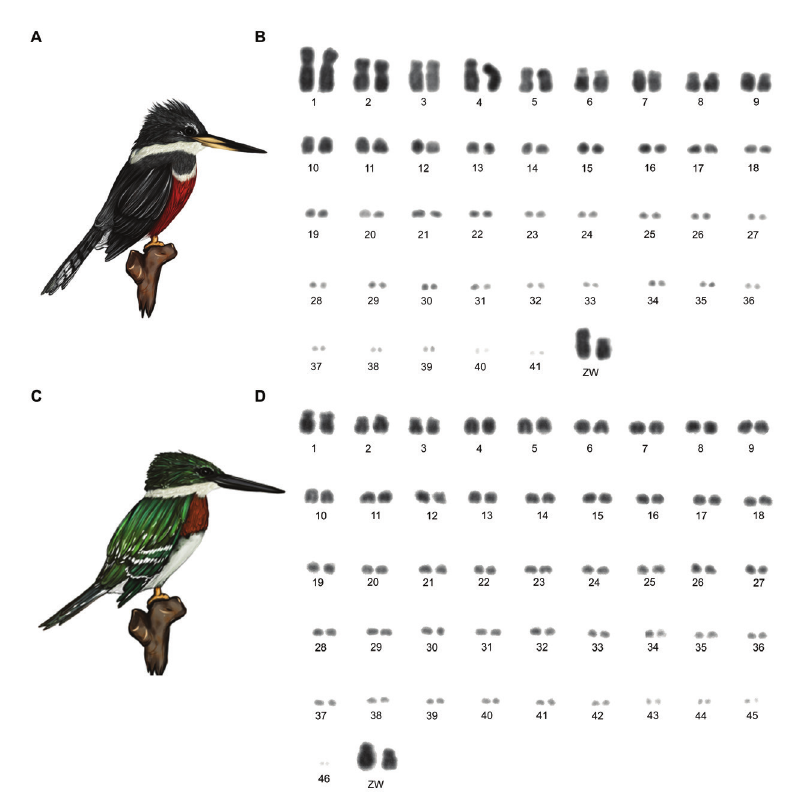
Figure 1. Ringed Kingfisher Megaceryle torquata ( A ) , and karyotype with 2n = 84 ( B ) . Green Kingfisher Chloroceryle americana ( C ), and karyotype with 2n = 94 ( D )